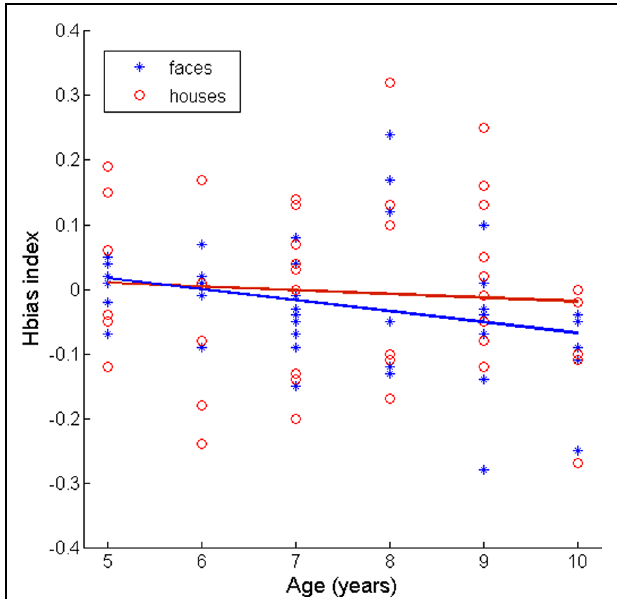
FIGURE 3 | Scatterplots depicting the value of the Horizontal bias index described in the text and age (binned here by years of age) for face and house targets. The overlaid lines depict the least-squares fit of each age vs. bias index relationship. We note that some values within age bins may be very close to one another and thus be difficult to see as separate in this